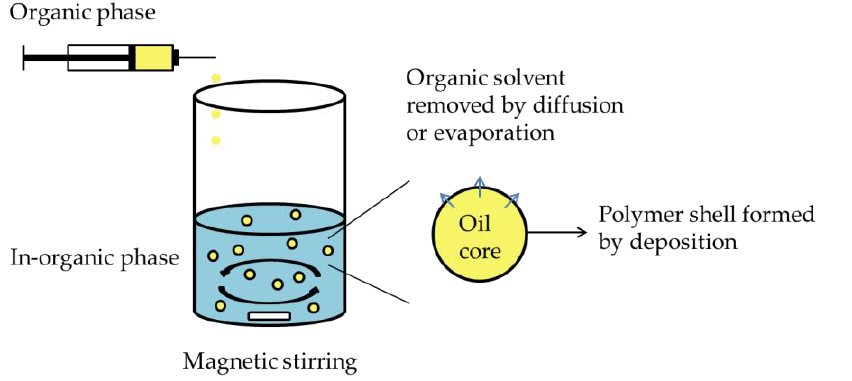
Figure 1. Schematic representation of nanocapsule formulation by interfacial deposition method.